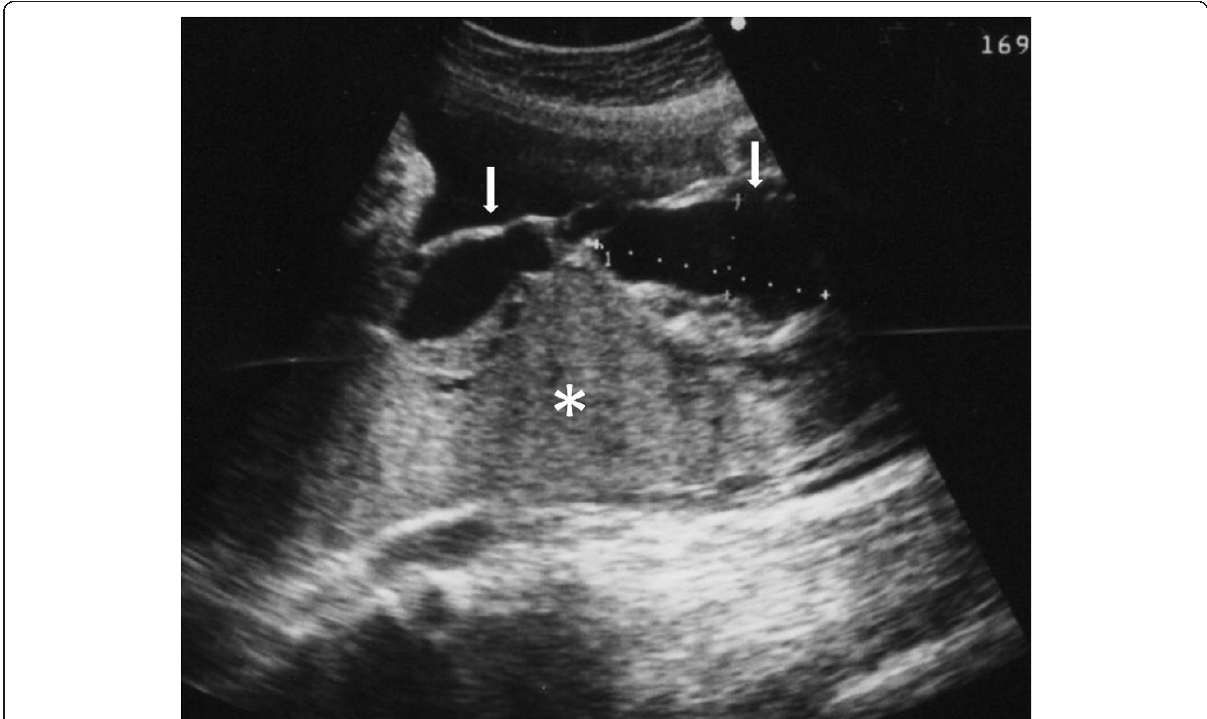
Figure 2 Transabdominal ultrasound study . Placental parenchyma (asterisk) and dilated subchorionic vessels (arrows) at 35 weeks ’ gestation. These vessels are up to 2.5 centimeters in